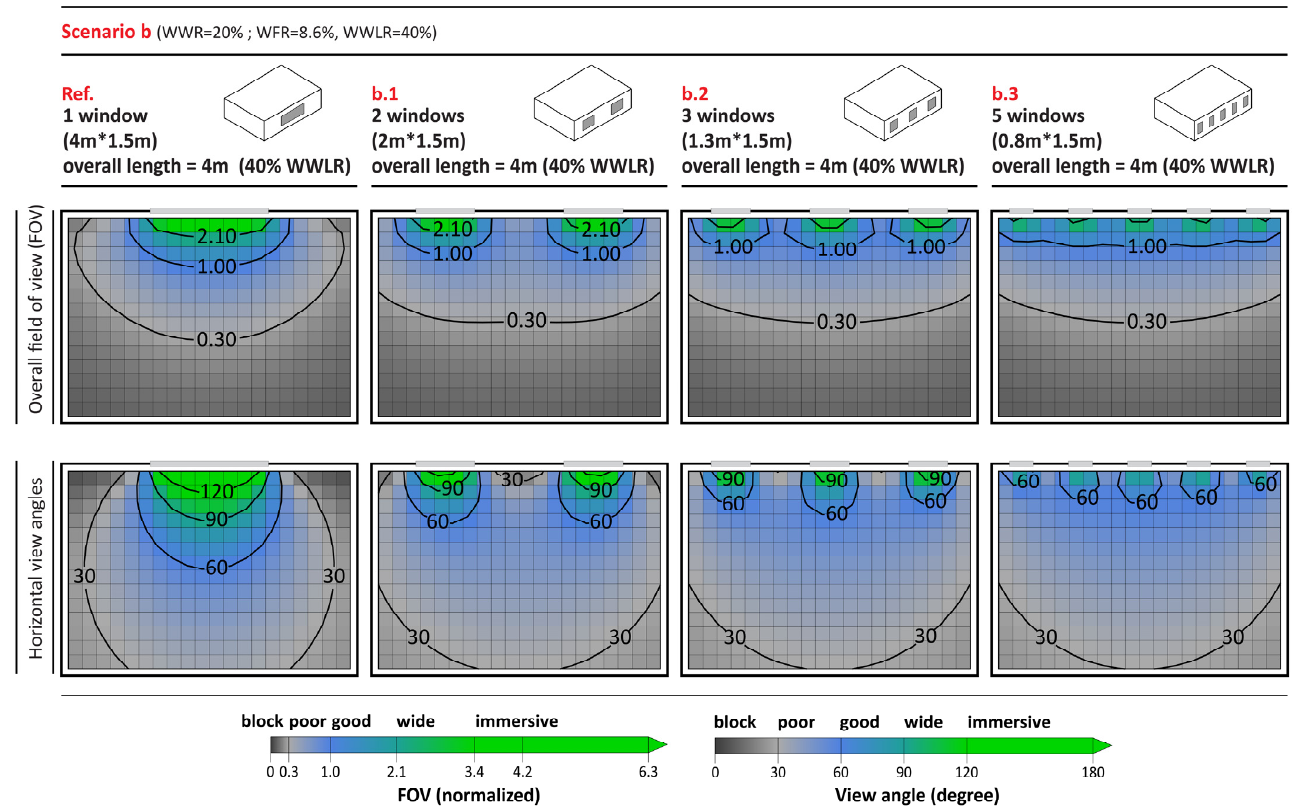
Figure 10. Impacts of dividing to multiple windows on the distributions of overall and horizontal FOVs for the case studies of scenario-b.